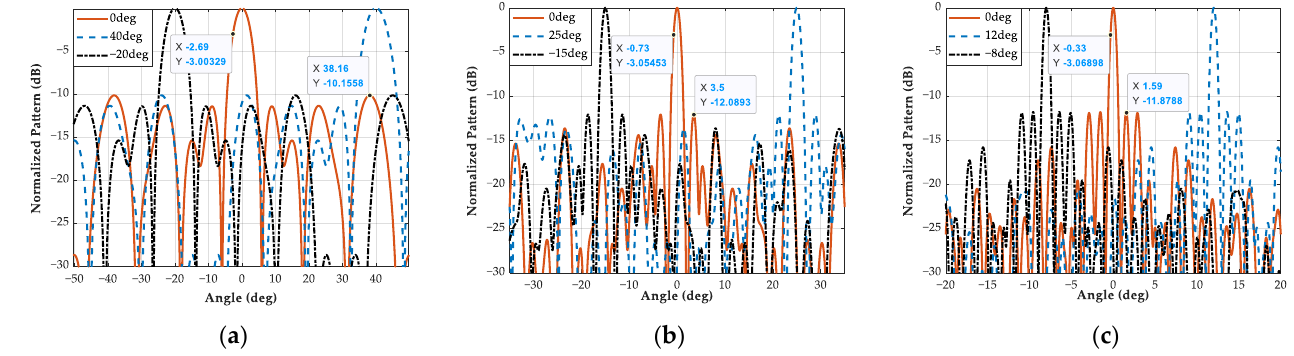
Figure 6. The optimal MAM-MIMO sparse array antenna patterns at different beams pointing: ( a ) SRS detection type; ( b ) MRS detection type; ( c ) LRS detection type.